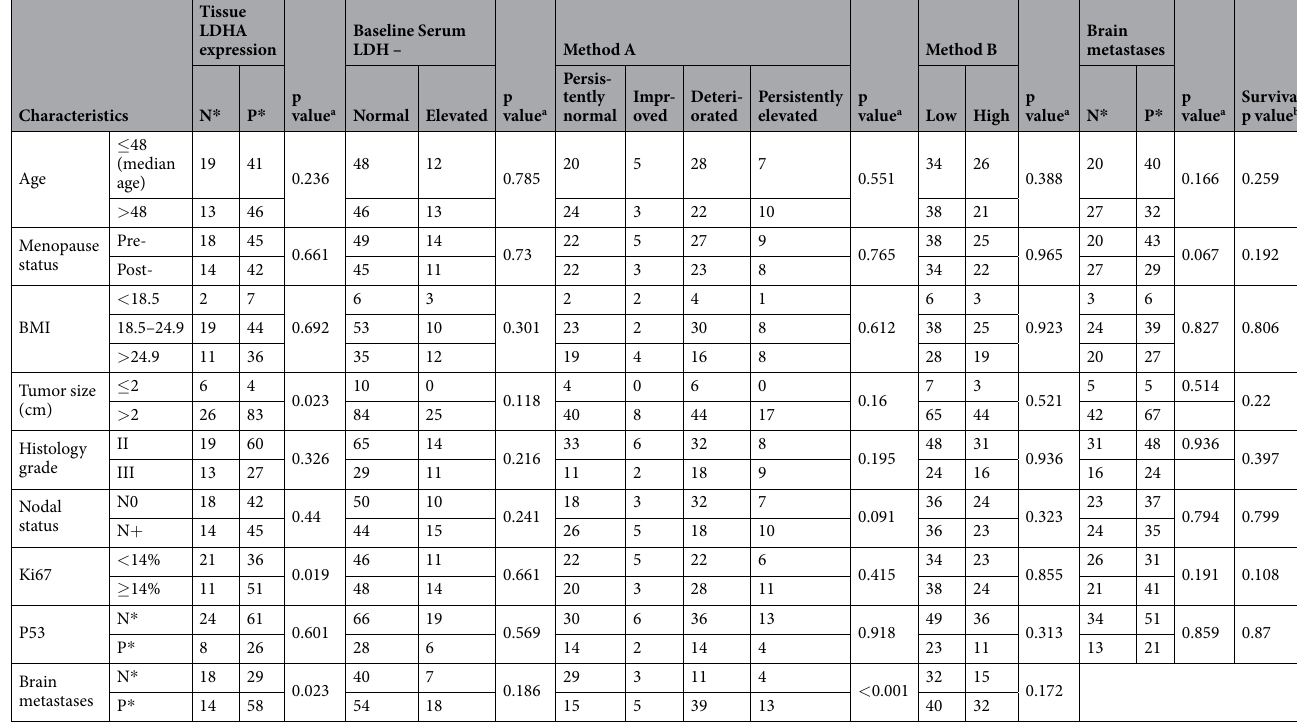
Table 1. The associations between clinicopathological characteristics and LDH/LDH-A status. b by Kaplan- Meier analysis a by two-sided Pearson’s exact test * P refers to positive, * N refers to